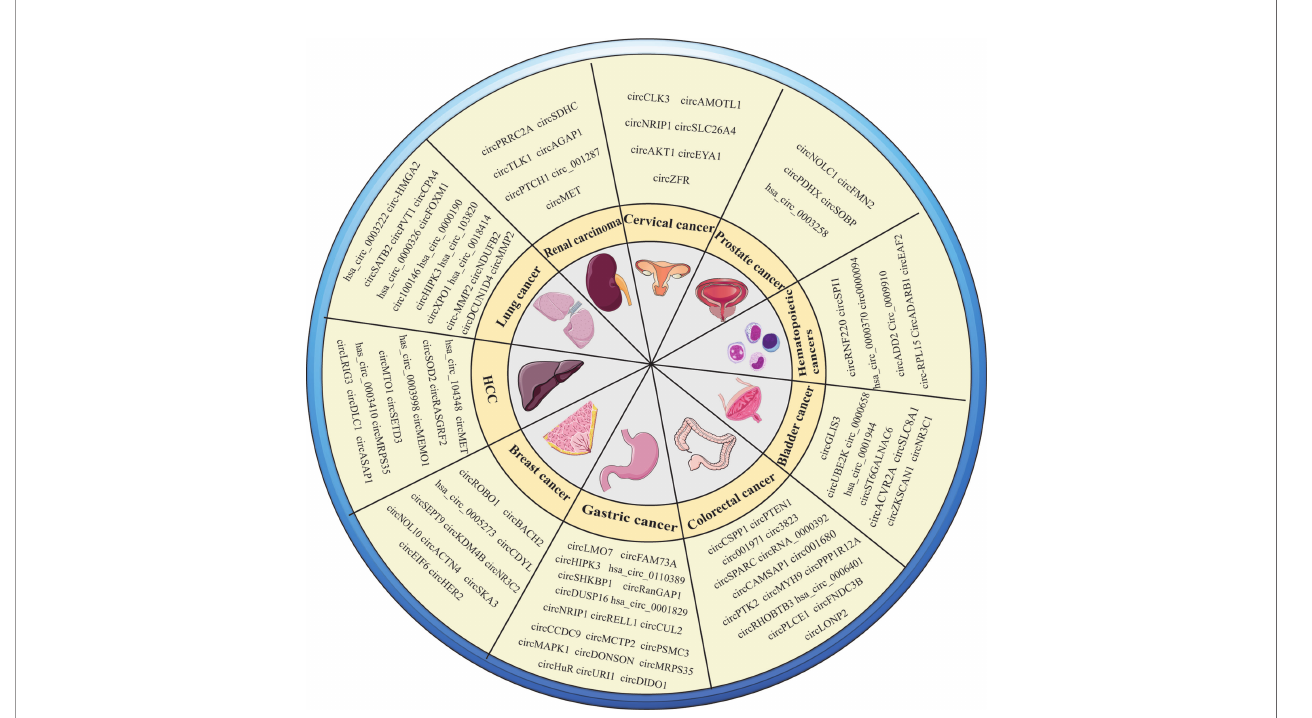
FIGURE 2 | Overview of circRNAs in various types of